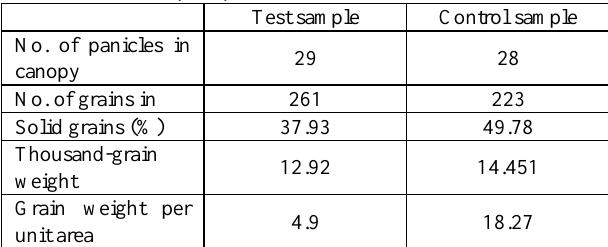
Table 4: Rice sample's performance